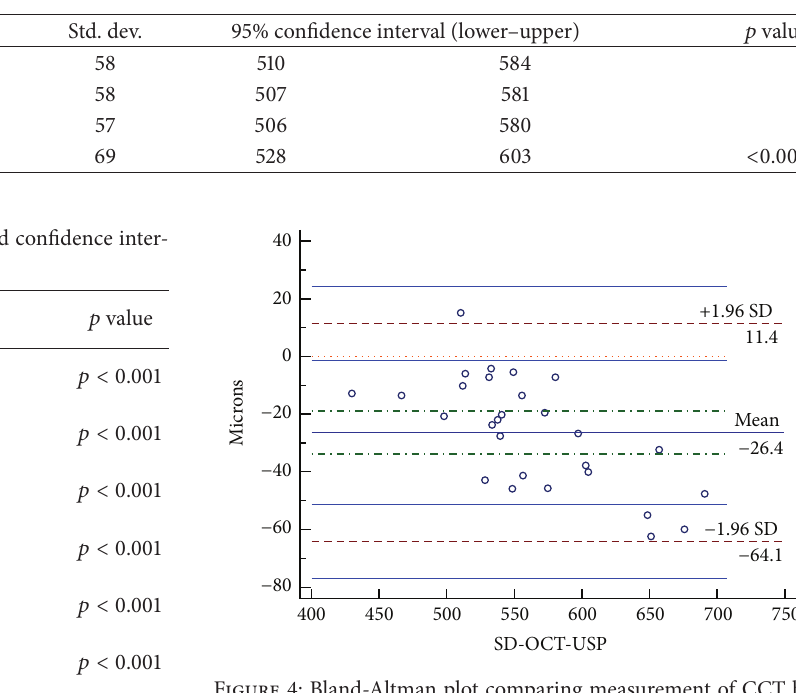
Figure 4: Bland-Altman plot comparing measurement of CCT by SD-OCT and